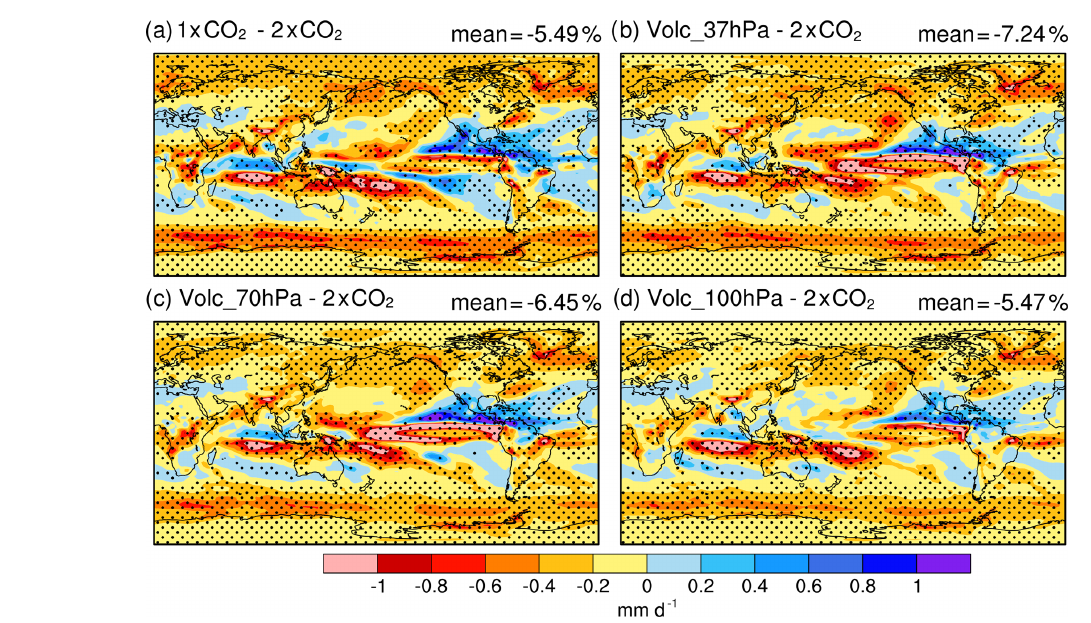
Figure 6. The spatial pattern of changes in precipitation relative to the 2XCO2 experiment (slab ocean simulations). The hatched areas show the regions where the changes are significant at the 5% significance level. The significance level is estimated using Student t test from 60 annual means of the experiments. Global mean value of the changes in each experiment is shown at the top right of each panel.